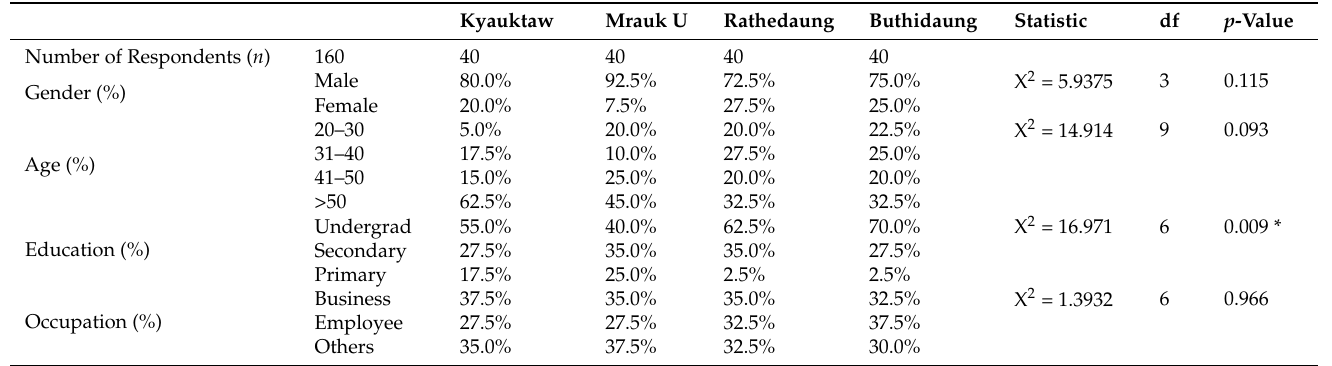
Table 1. Multi-stakeholder workshop participants’ characteristics in the study area.